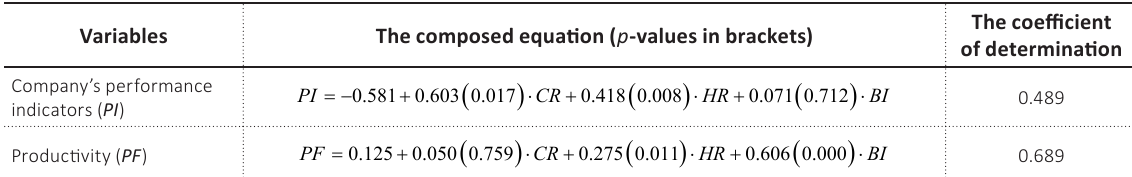
Table 2. The impact of cooperative relationships and the infrastructure of business and human resources on company’s performance and productivity factors Variables The composed equation ( p -values in brackets) The